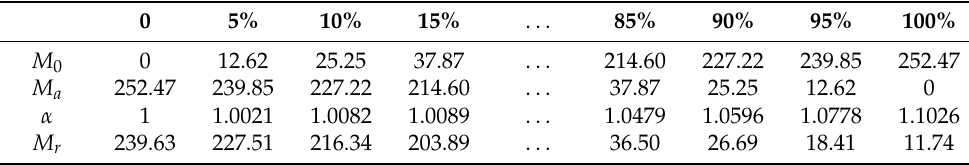
Table 4. Data of a concrete piston at different life prediction points.